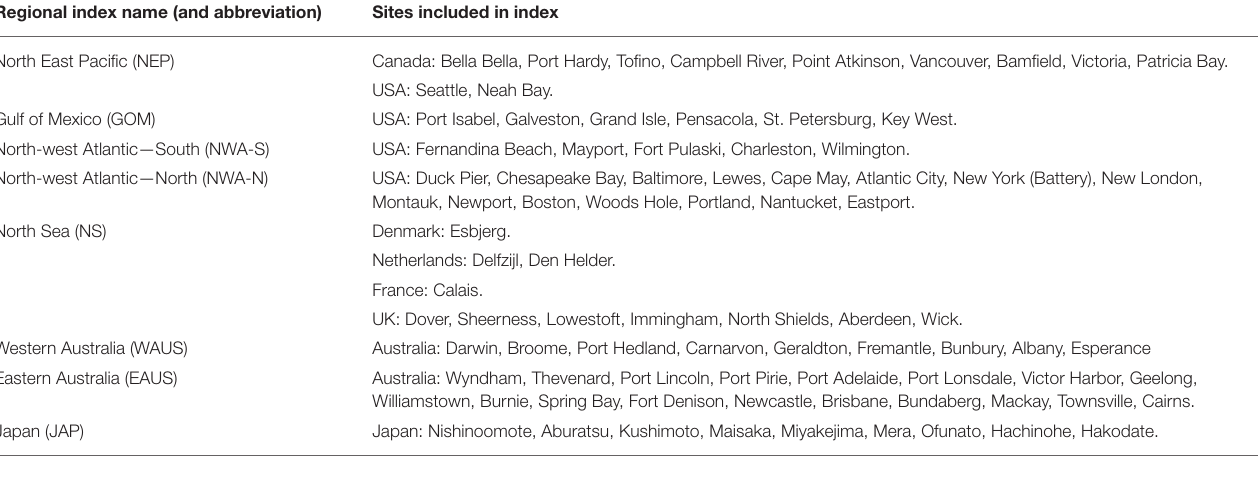
TABLE 1 | Details of sites included in each of the regional indices.